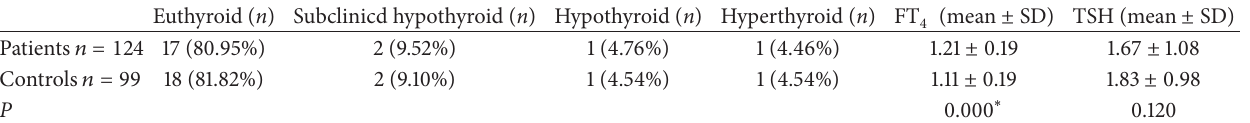
Table 2: Thyroid hormone levels and autoimmune thyroiditis status in the patient and control